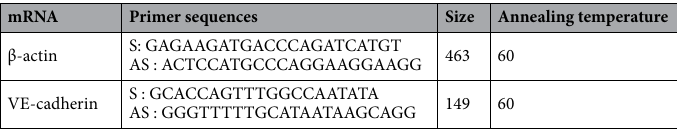
Table 1. Primers used in this